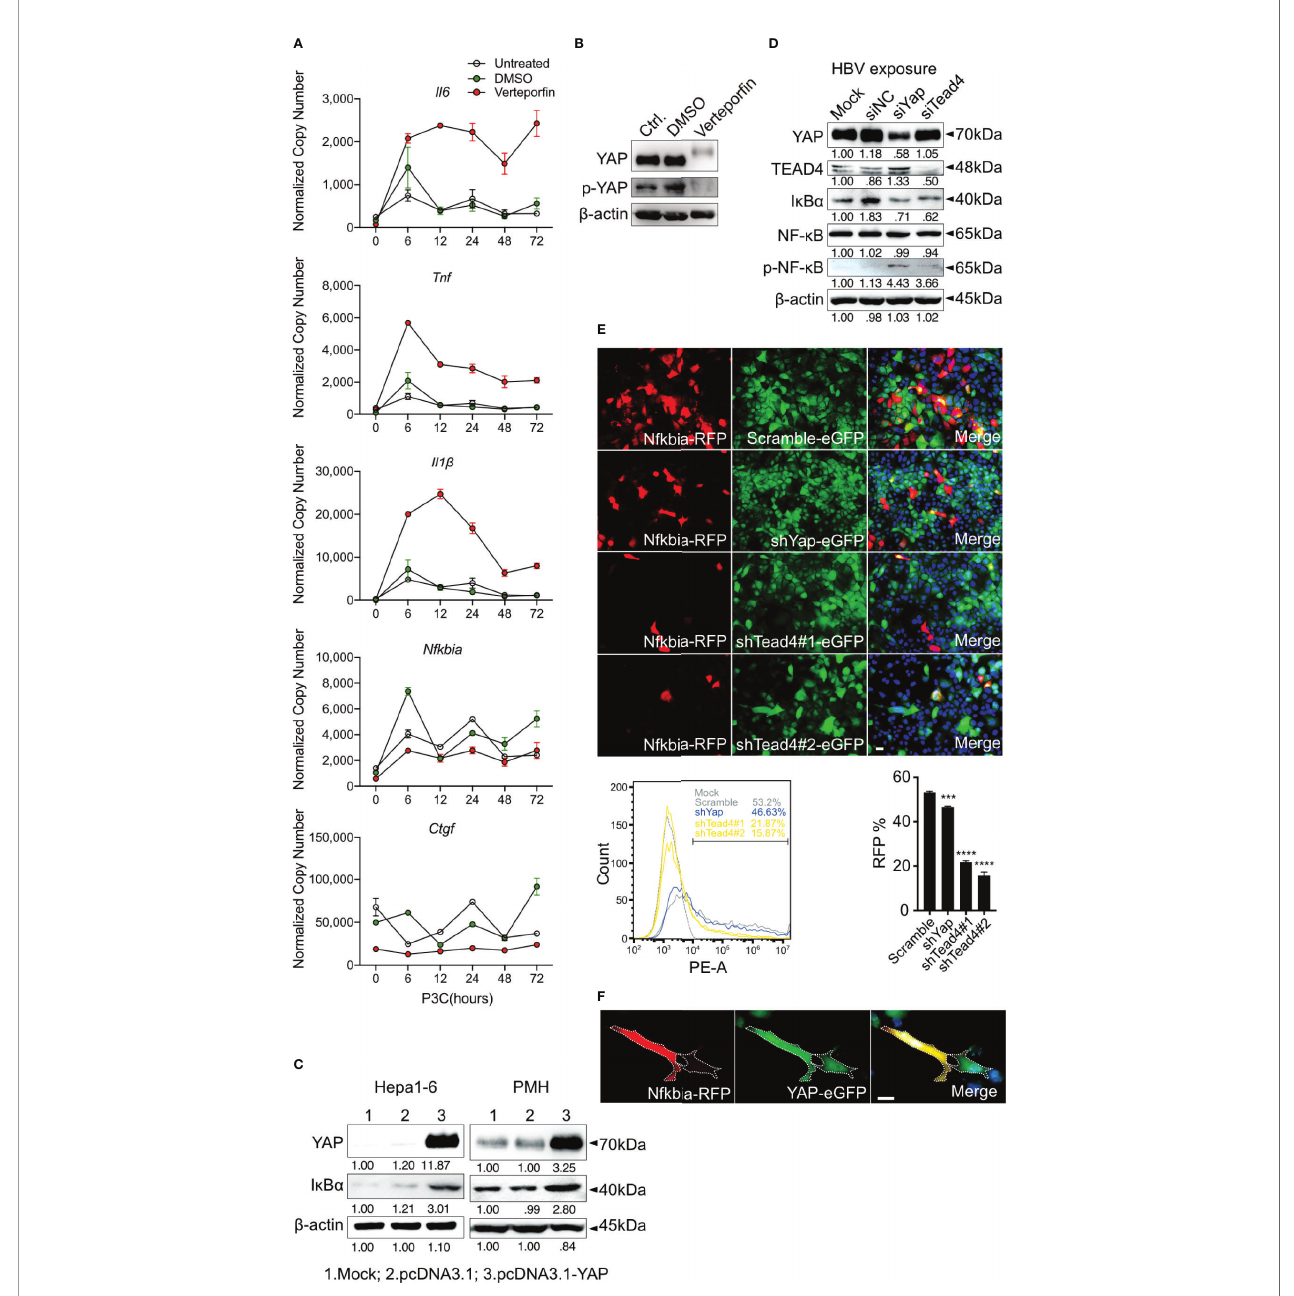
FIGURE 5 | Hippo signaling regulates the in fl ammatory immune response by suppressing YAP/TEAD4-mediated transcription. PMHs were pretreated with Vertepor fi n [1 m M] or DMSO for 24h and treated with Pam3CSK4 [1µg/ml] for different length of time. Gene expression of Il6, Tnf, Il1 b , Ctgf and Nfkbia was determined by quantitative PCR (A) , (normalized to Actb , mean ± SEM, n=3 independent experiments). Representative YAP expression was determined by western blot in PMHs treated with Vertepor fi n or DMSO for 24h, n=3 independent experiments (B) . Western blotting revealed the expression of YAP and I k B a in Hepa1-6 cells and primary murine hepatocytes (PMHs) 48h after the overexpression of YAP, representatively. Gel images were obtained with ADVANCED Fluorescence and ECL Imager, n=3 independent experiments (C) . Western blot analysis detected the expression of YAP, TEAD4, I k B a , NF- k B and phosphorylated NF- k B in PMHs treated with 50nM siYap, siTead4 or siNC (non-silencing control) for 48h followed by HBV exposure for 2h, representatively. Gel images were obtained with ADVANCED Fluorescence and ECL Imager. N=3 independent experiments (D) . Hepa1-6 cells stably transfected with GFP-inducing shRNA plasmids (Scramble, Yap, Tead4) were co-transfected with RFP reporter plasmid to assess Nfkbia promoter activity. Representative ICC images and fl ow cytometry were applied to determine Nfkbia promoter-driven RFP expression with Olympus BX51 (20x objective) and CytoFLEX S fl ow cytometer. N=3 independent experiments (E) . Representative ICC images of Hepa1-6 cells showing Nfkbia promoter-driven RFP intensity in cells overexpressing GFP-associated YAP (F) . ***p-value < 0.001; ****p-value < 0.0001; DMSO, solvent control; scale bar, 20 m m; kDa,